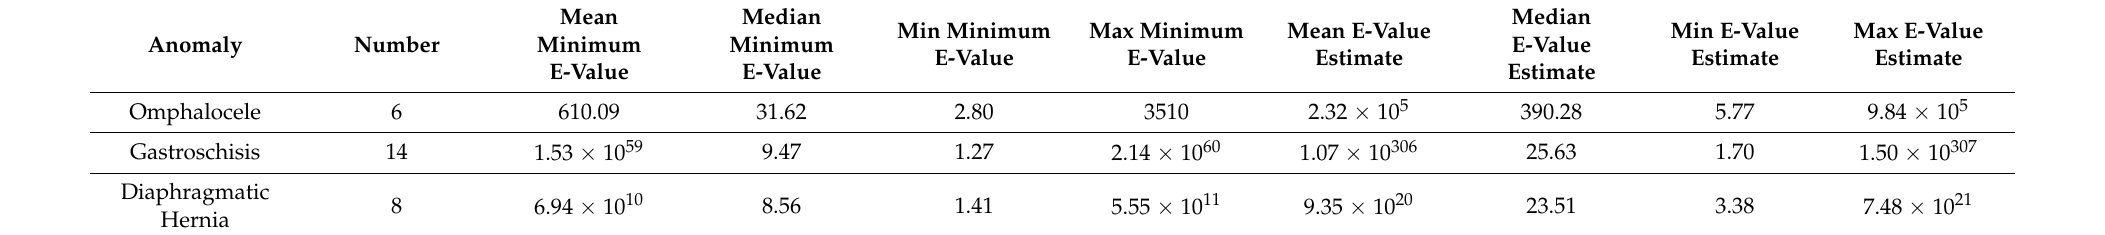
Table 10. Summary of E-Values by